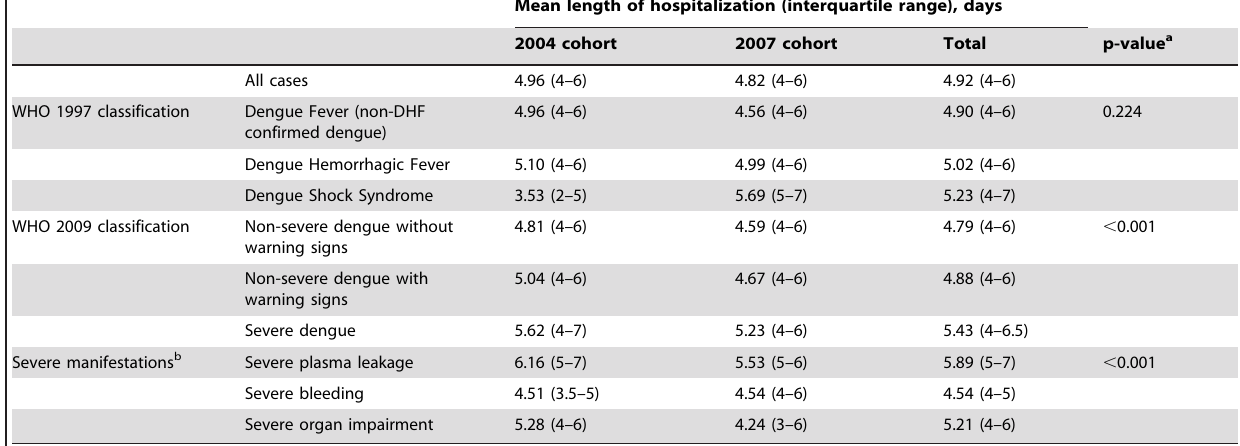
Mean length of hospitalization (interquartile range), days